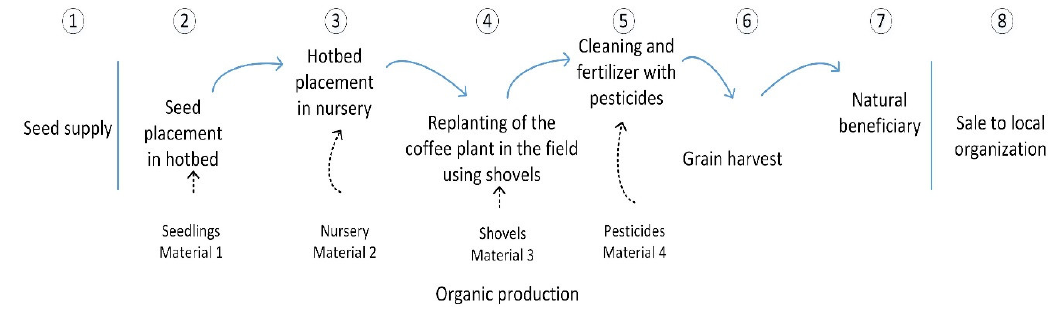
Figure 2. Process and materials of coffee production.